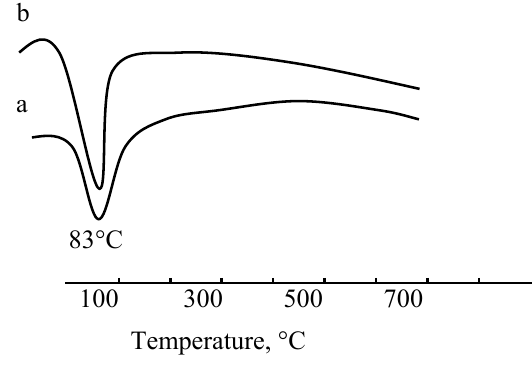
Figure 1 . DTA curves of the activated carbon support. Samples are as follows: ( a ) calcined sample; and ( b ) as-is